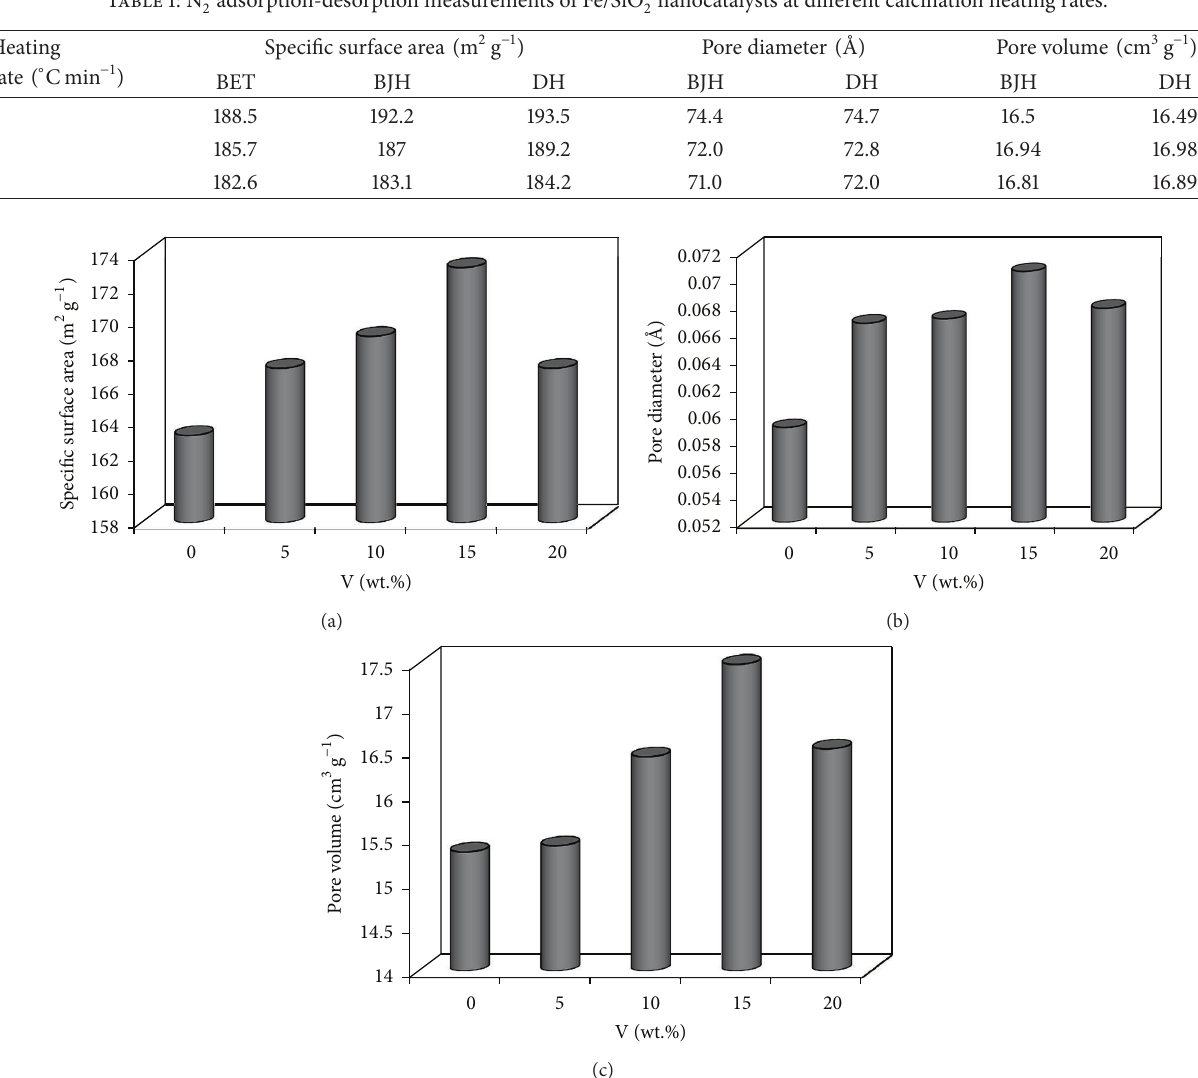
Figure 7: N 2 adsorption-desorption measurements of Fe-V/SiO 2 nanocatalysts at different V